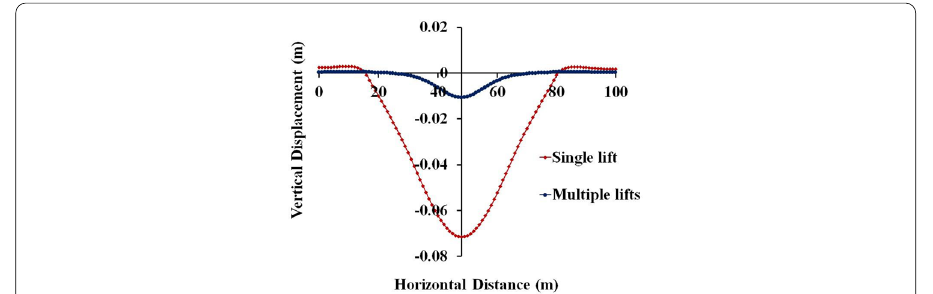
Fig. 9 Settlement profile along the base of the earthen dam due to adoption of single-lift and multiple-lift techniques for simulating the construction